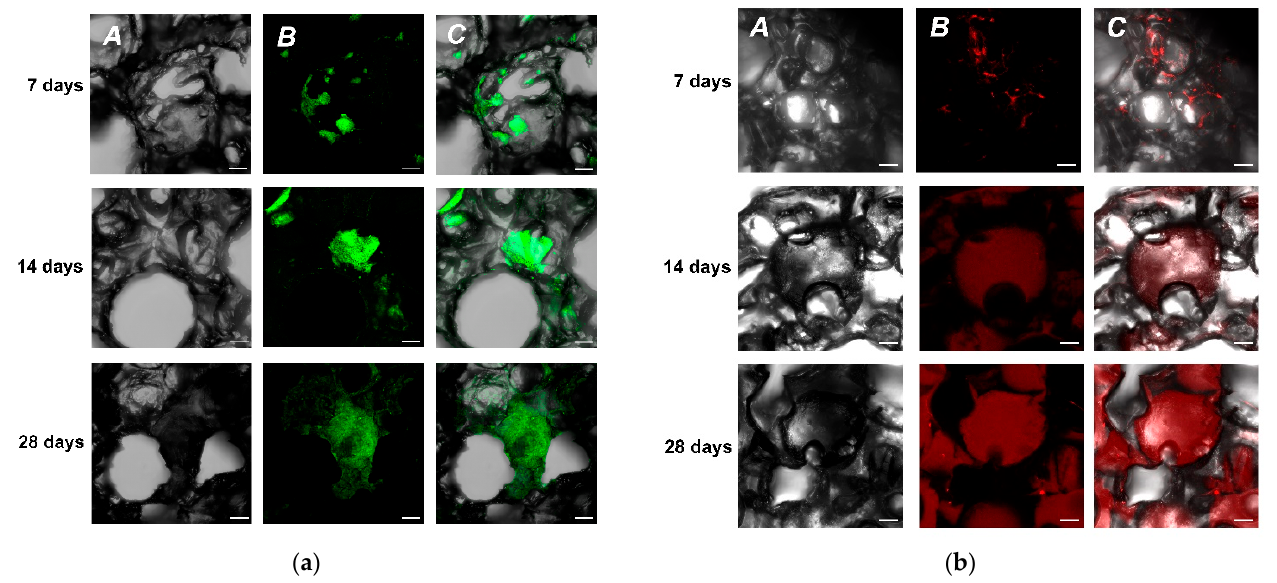
Figure 2. Confocal images of cell growth of SH-SY5Y-F15 and primary mice hippocampal culture on UHMWPE matrix at 7, 14 and 28 days. ( a ) SH-SY5Y-F15 cells: panel A—3D porous structure of UHMWPE, phase contrast (grey); panel B—SH-SY5Y constitutively expressing GFP (green); ( b ) primary culture cells: panel A—3D porous structure of UHMWPE, phase contrast (grey); panel B—primary hippocampal culture stained with Rhodamine-phalloidin (red). Panel C on ( a ) and ( b )—merged images of panels A and B. Scale—100 µm.